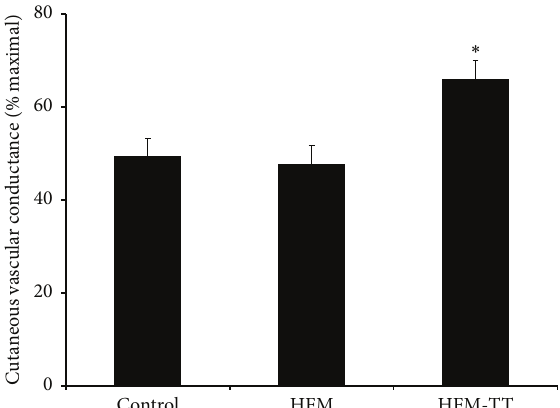
Figure 2: Initial peak %CVC max . Initial peak %CVC max for the control, high fat meal (HFM), and high fat meal plus TT (HFM-TT) trials. There was no effect of the HFM on the initial peak compared to the control trial. Initial peak was augmented in the HFM-TT trial compared to the control and HFM trials. ∗ 𝑃 < 0.05 versus control and HFM trials. Data are group mean ± SEM.